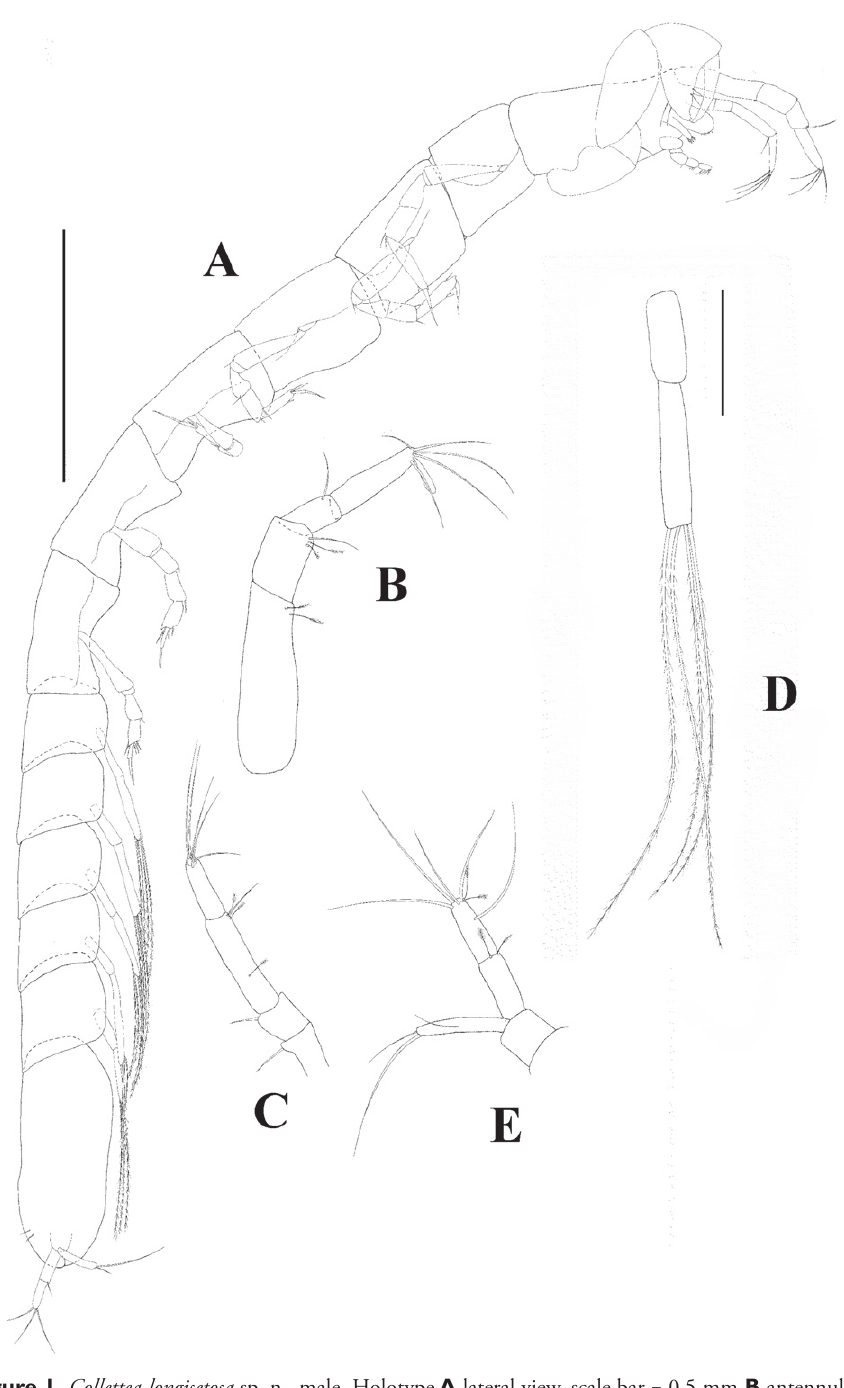
Figure 1. Collettea longisetosa sp. n ., male. Holotype A lateral view, scale bar = 0.5 mm B antennule C antenna D pleopod E uropod. Scale bars = 0.1